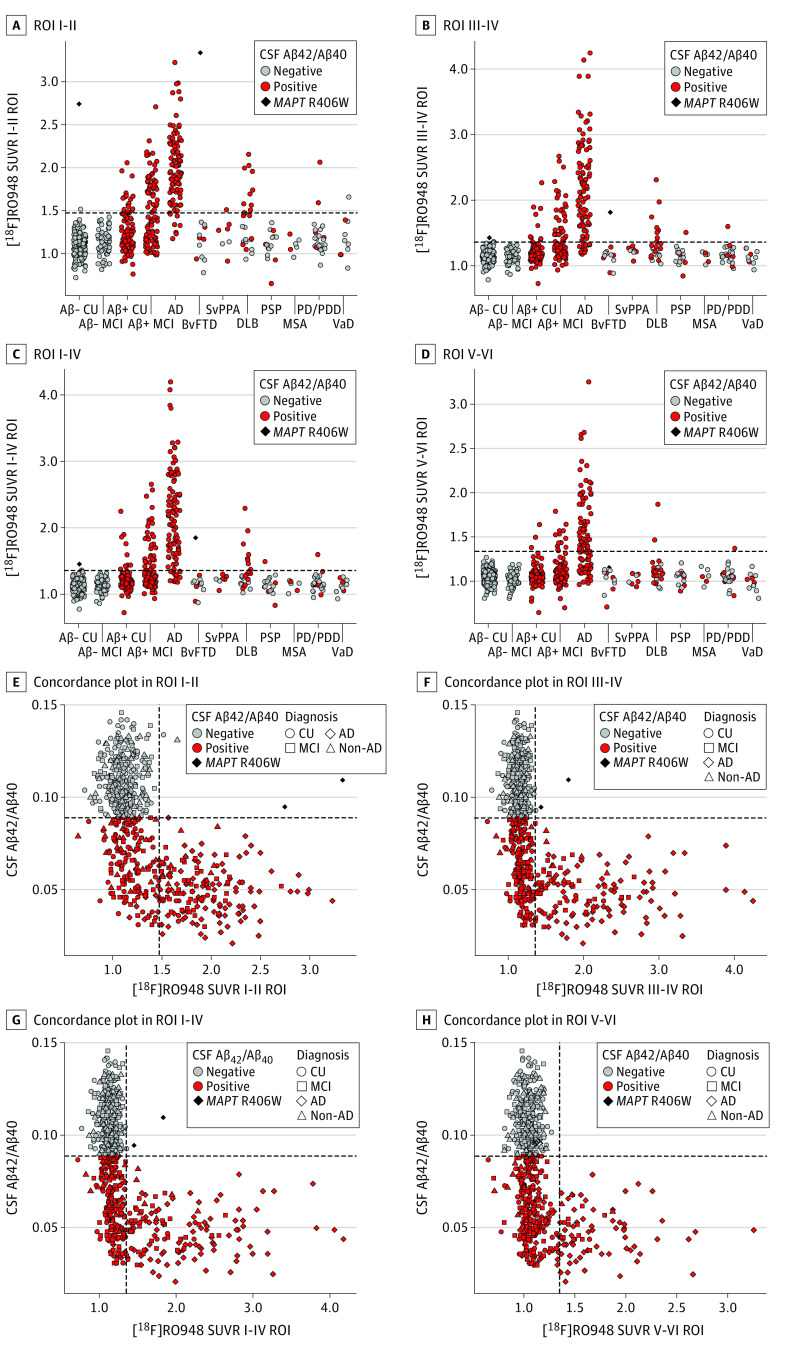
Mean RO948 F 18 ([18F]RO948) Standardized Uptake Value Ratios (SUVRs) Across Diagnostic Groups Within Tau-Imaging Regions of Interest (ROIs)ROI groupings were I-II (A), III-IV (B), I-IV (C), and V-VI (D). Concordance plots are shown between the [18F]RO948 SUVR and cerebrospinal fluid (CSF) amyloid β42 and β40 (Aβ42/Aβ40) for ROIs I-II (E), III-IV (F), I-IV (G), and V-VI (H). The horizontal dashed lines indicate the cutoffs for tau positivity across the ROIs, defined using the mean plus 2.5 SDs in Aβ-negative young controls (I-II ROI>1.48; III-IV and I-IV ROIs >1.36; V-VI ROI>1.35). The vertical dashed line indicates the cutoff for Aβ-positivity (CSF Aβ42/Aβ40<0.089, as established in an independent population by the neurochemistry laboratory at the Sahlgrenska University Hospital, Mölndal, Sweden). Abbreviation expansions appear in caption to Figure 1. VaD indicates vascular dementia.